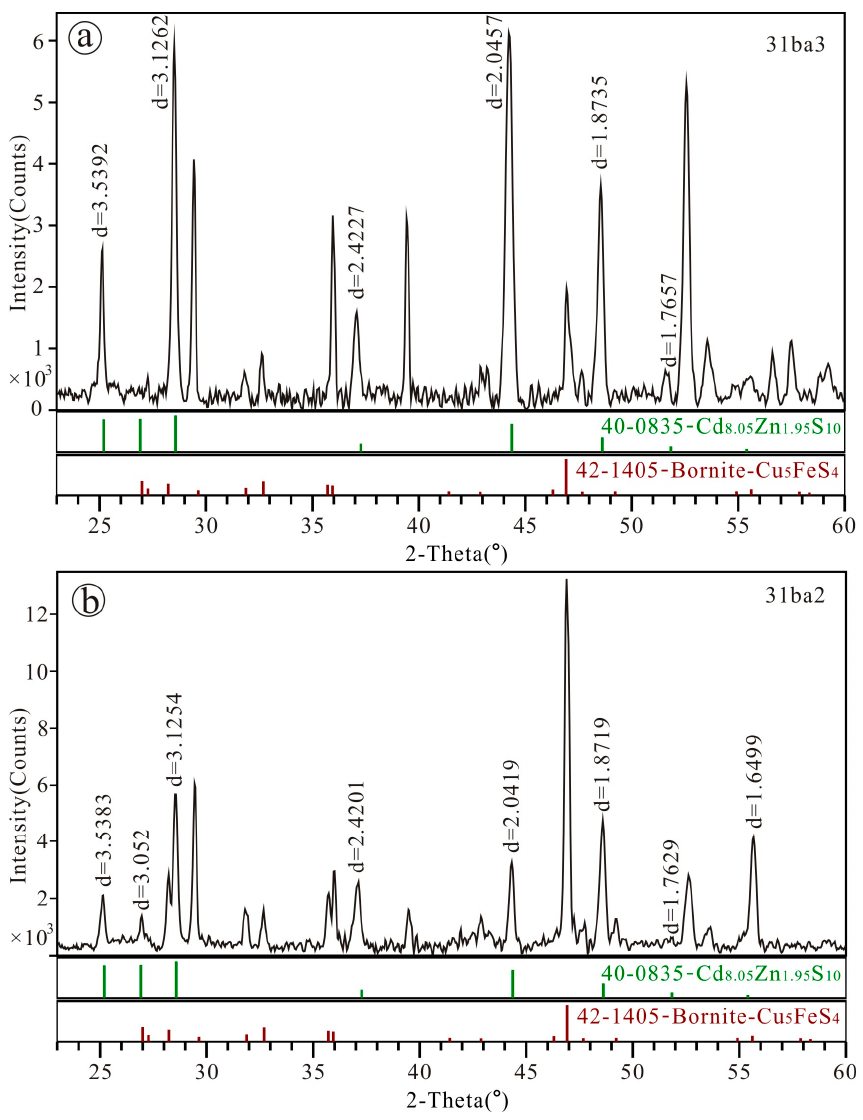
Figure 10. X-ray diffraction patterns of zincian greenockite from two analysis spots ( a ) spot 31ba3, and ( b ) spot 31ba2 (peak data listed in Table 4) with the corresponding the International Centre for Diffraction Data references.